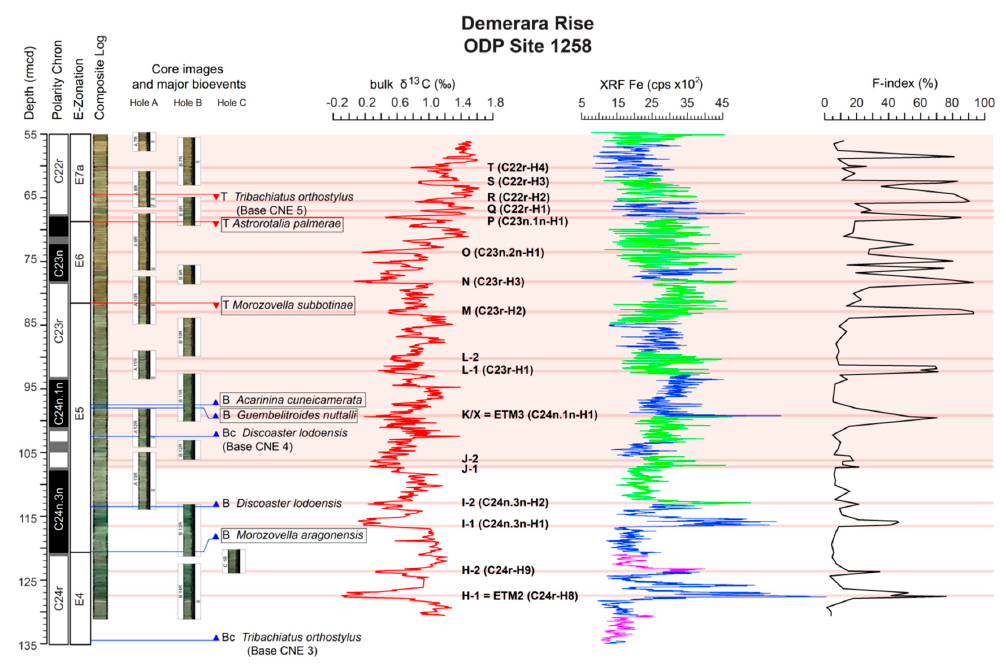
Figure 2. Photographs of individual sediment cores from Holes A, B, C (photograph are located at http://iodp.tamu.edu/janusweb/imaging/photo.cgi ) along with the composite log, the planktic foraminifera E Zonation scheme [52] as modified by [53], plotted against bulk stable carbon isotopes [15], XRF (X-Ray Fluorescence) Fe contents [49], and fragmentation index (this work). Also shown are the positions of significant planktic foraminiferal (this work, within boxes) and calcareous nannofossil biohorizons [49]. The main carbon isotope excursions (CIEs) are labelled according to [2,15,18].